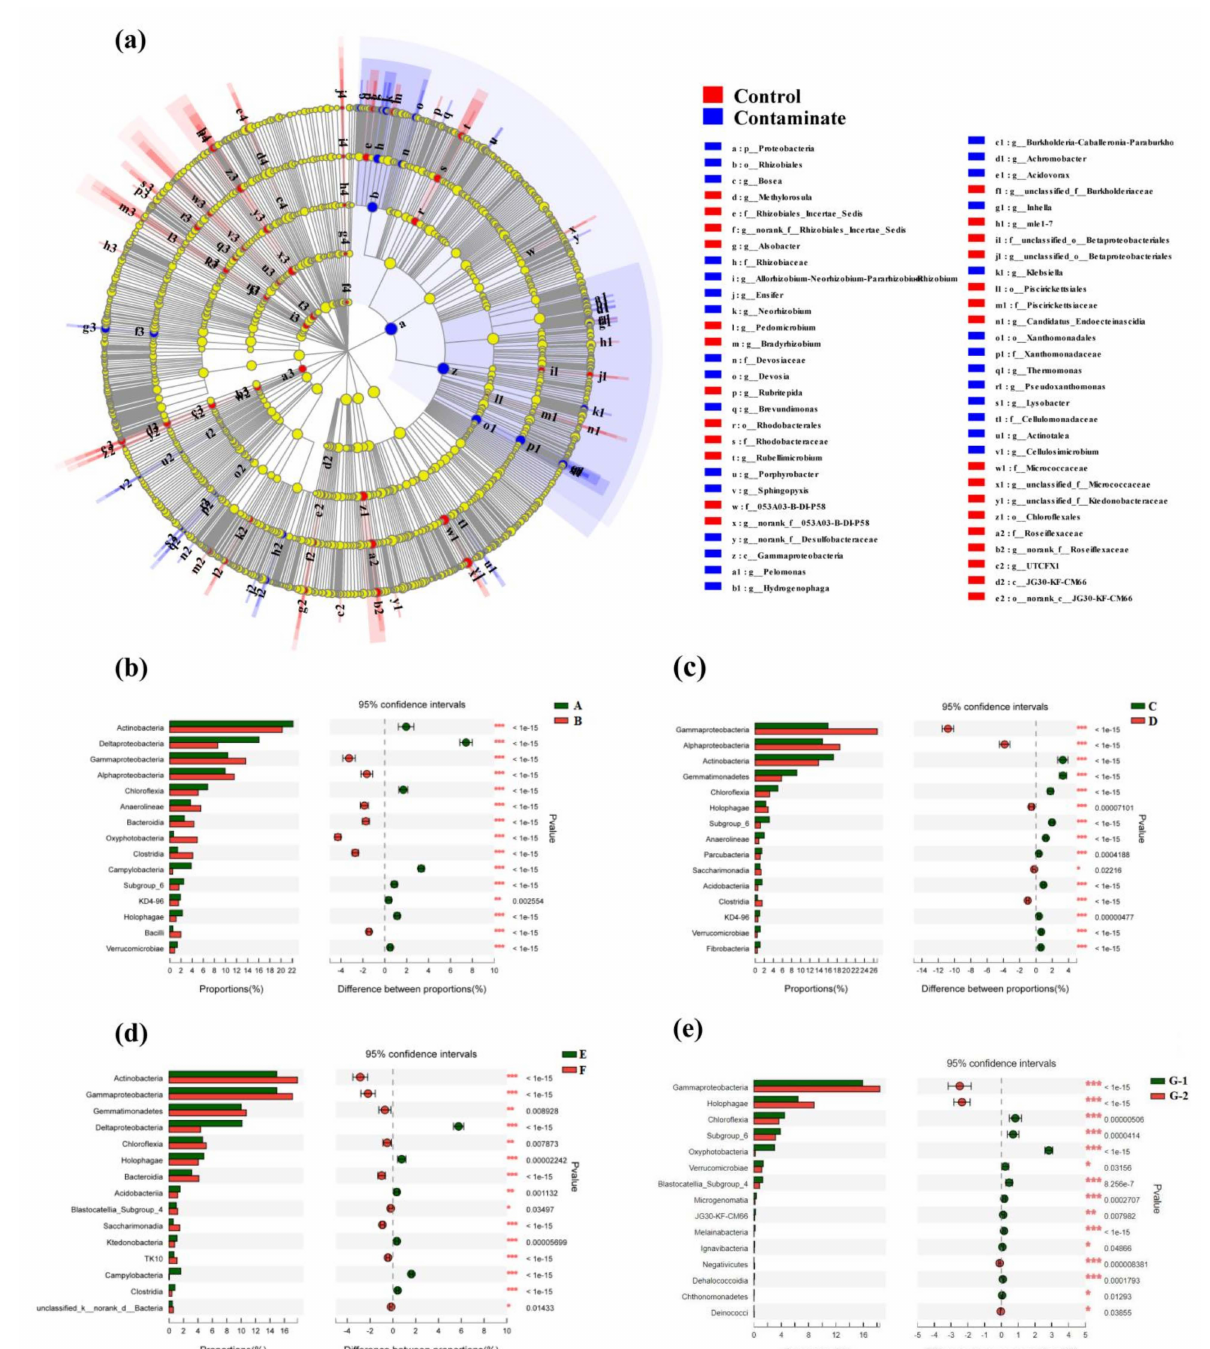
Figure 5. Differences of rhizosphere soil microbial community abundance in different cultivation modes of Iris under Cr stress ( a ): Lefse multi-level discriminant analysis of species difference showed that different color nodes represented the microbial groups that were significantly enriched in the corresponding groups and had a significant impact on the differences between groups. The light yellow nodes indicate the microbial groups that were not significantly different in different groups or had no significant effect on the differences between groups. ( b – e ): Wilcoxon rank-sum test bar plot on the class level. Each column corresponding to the species represents the relative abundance of the species in each sample, and different colors represent different samples. The middle region is